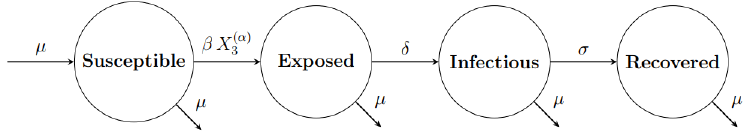
Figure 1. Schematic diagram of the susceptible-exposed-infectious-recovered (SEIR) model depicting transitions between different compartments.